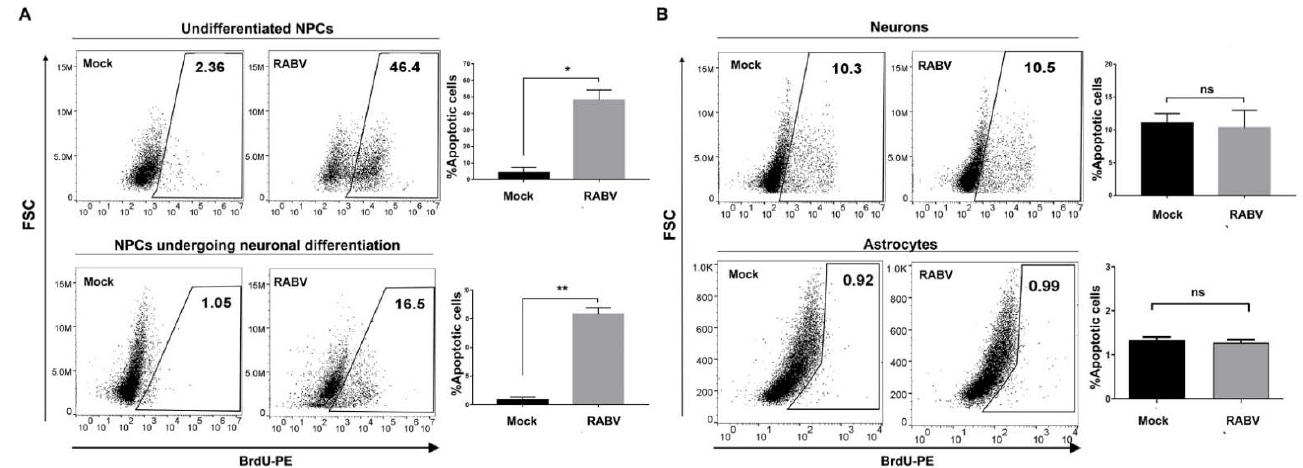
Figure 4. RABV infection induced apoptosis in hiPSC-derived NPC but not neurons and astrocytes. Cells were infected with RABV-TH at MOI 0.5. NPCs were maintained in NPC media (undifferentiated stage) or in NPC media with the withdrawal of FGF2 (NPCs undergoing neuronal differentiation). Neurons and astrocytes were maintained in NPC media without FGF2, and astrocyte media supplemented with FBS. To examine apoptosis in each cell type by flow cytometry, ( A ) NPCs at different stages included undifferentiated NPCs, and NPCs undergoing neuronal differentiation were harvested at 72 hpi and 5 days post infection (dpi), respectively, and ( B ) neurons and astrocytes were harvested at 72 hpi. Percentages of apoptotic cells shown are representative of triplicate. Error bars represent means ± SEM. Data were analyzed by an unpaired- t test. ns, p > 0.05; * p < 0.05; ** p < 0.01.